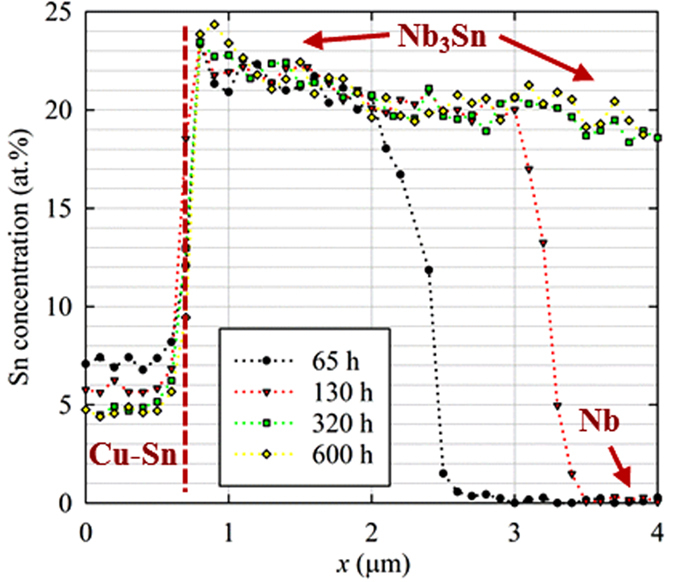
The measured XSns of a Cu-Sn/Nb3Sn/Nb system after various annealing times at 650 °C.The standard deviation in the Sn content measurements is around ±0.5 at.%.